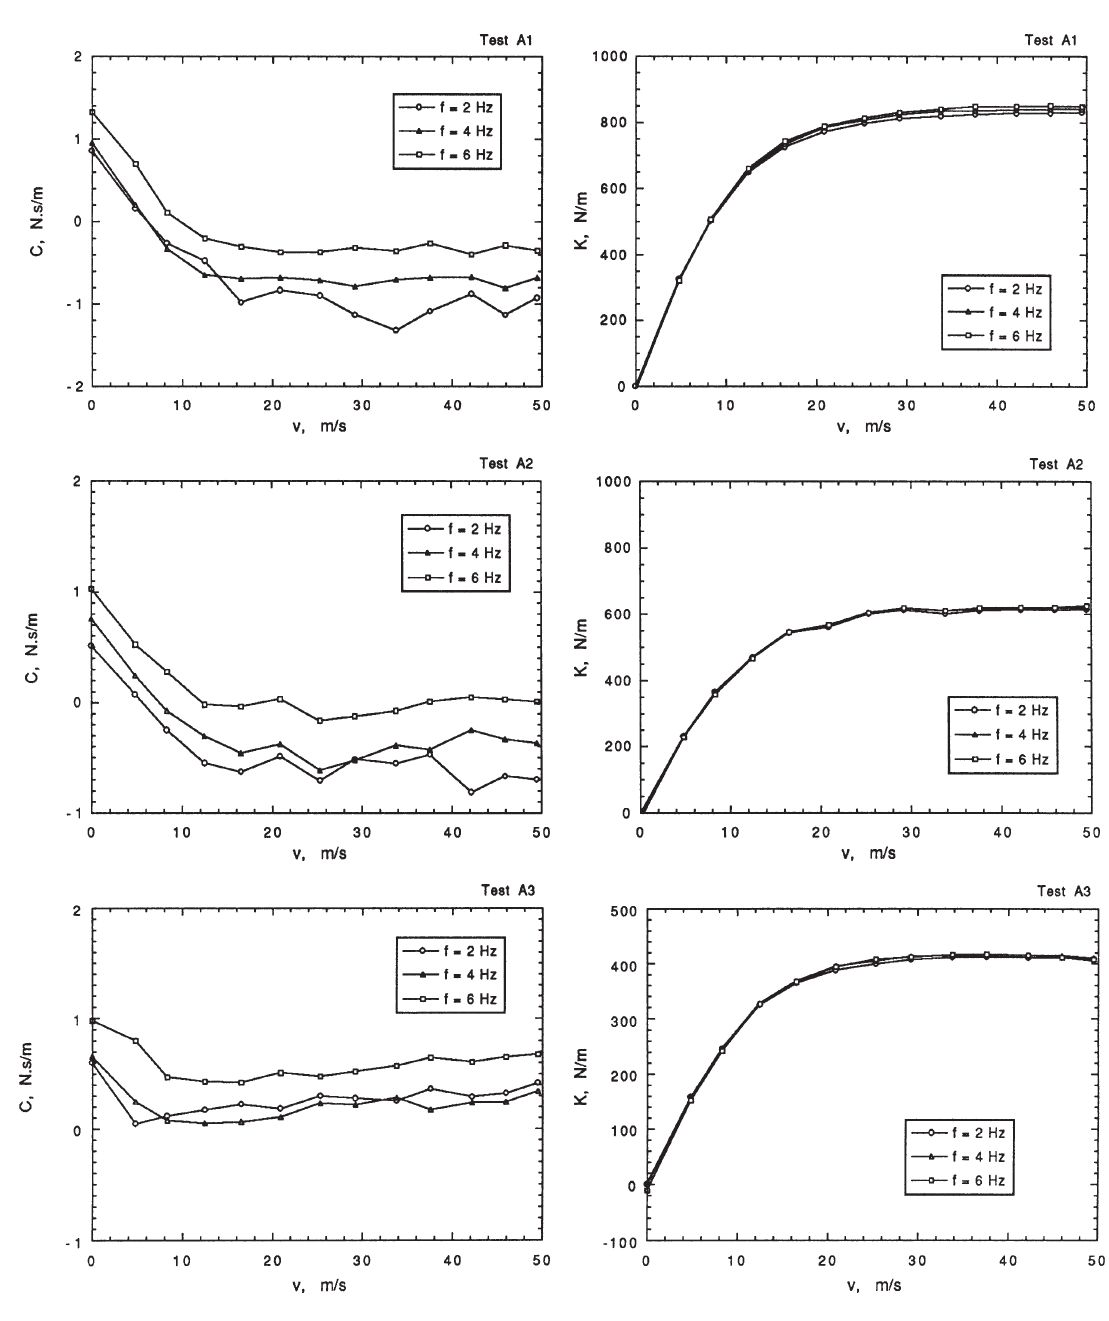
Fig. 5. Magnetic damping and stiffness for series A tests (continued on the next page).